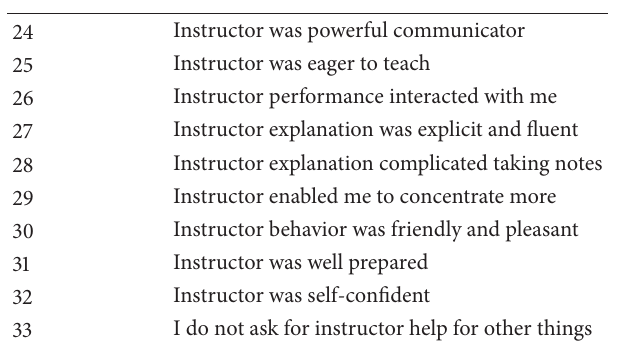
Table 7: Assessment data student evaluations using a Likert-scale (Section-C).